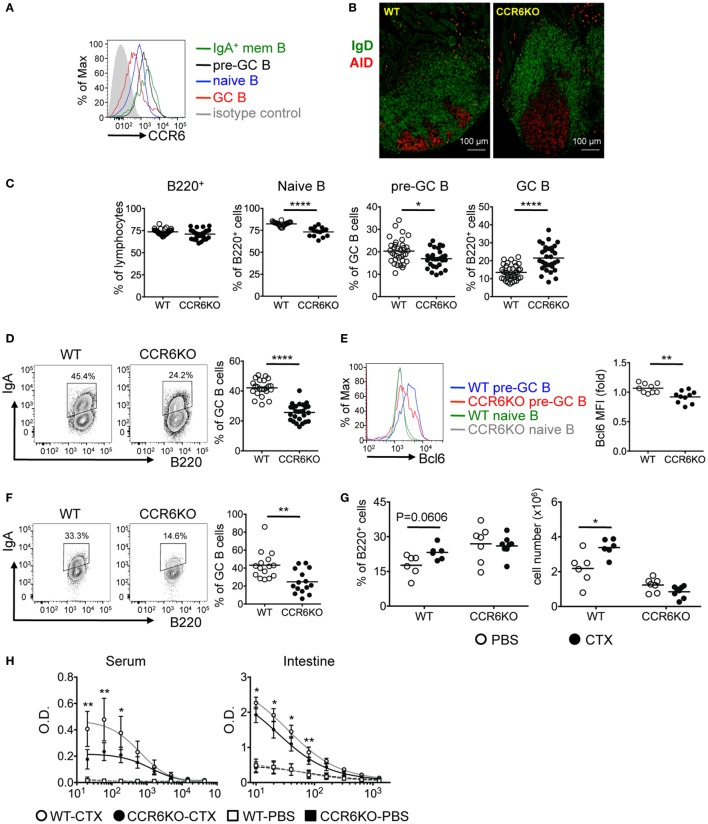
CCR6−/− mice show enlarged GC and fewer IgA-bearing germinal centers (GC) B cells in Peyer’s patches (PPs). (A) CCR6 expression on B-cell subsets in PPs was determined by FACS analysis. B cell subsets analyzed are naive B cells (B220+CD38+CD95−IgD+), pre-GC B cells (B220+CD95+PNAhiIgD+), GC B cells (B220+CD95+PNAhiIgD−), and IgA+ memory B cells (B220+CD38+CD95−IgD−IgA+). (B) Cryosections of PPs from WT and CCR6−/− mice. Sections were stained with AID (red) and IgD (green). PPs from two WT mice and two CCR6−/− were processed and examined. Representative PPs from the distal part of small intestine are shown. (C) FACS analysis of B-cell subsets in PPs of WT and CCR6−/− mice. The frequencies of total B cells (B220+), naive B cells (B220+CD95−PNAintIgD+IgM+), pre-GC B cells (B220+CD95+PNAhiIgD+), and GC B cells (B220+CD95+PNAhi) are shown. (D) PP lymphocytes from WT and CCR6−/− mice were subjected to FACS analysis of IgA-bearing GC B cells (B220+CD95+CD38−IgA+). Representative contour plots (left panel) and the frequency (right panel) of IgA-bearing GC B cells are shown. (E) PP lymphocytes from WT and CCR6−/− mice were subjected to FACS analysis of pre-GC B cells (B220+CD95+PNAhiIgD+) along with intracellular staining of Bcl6. A representative histogram is shown (left panel), and the mean fluorescence intensity (MFI) of Bcl6 is shown (right panel). (F) Irradiated Rag1−/− mice were reconstituted with mixed bone marrow from WT and CCR6−/− mice (1:1). Three months later, PP lymphocytes were isolated and analyzed for IgA-bearing GC B cells. Representative contour plots (left panel) and the frequency (right panel) of IgA-bearing GC B cells are shown. (G,H) WT and CCR6−/− mice were orally immunized with 10 µg of cholera toxin (CTX) three times with 7 days intervals. Mice were sacrificed on day 7 after final immunization. PP lymphocytes were subjected to FACS analysis of GC B cells (B220+CD95+PNAhi). The frequency (left panel) and number (right panel) of GC B cells are shown (G). Mouse sera were adjusted to an equal IgA concentration (100 mg/ml), and intestinal tissue extracts were adjusted to an equal protein concentration (5 mg/ml). Sera and intestinal samples were serially diluted, followed by measurement of anti-CTX IgA with ELISA (H). Each symbol represents one mouse. Data are a compilation of six (C), four (D,E), three (F), or two (G,H) independent experiments (*p < 0.05; **p < 0.01; ****p < 0.0001).